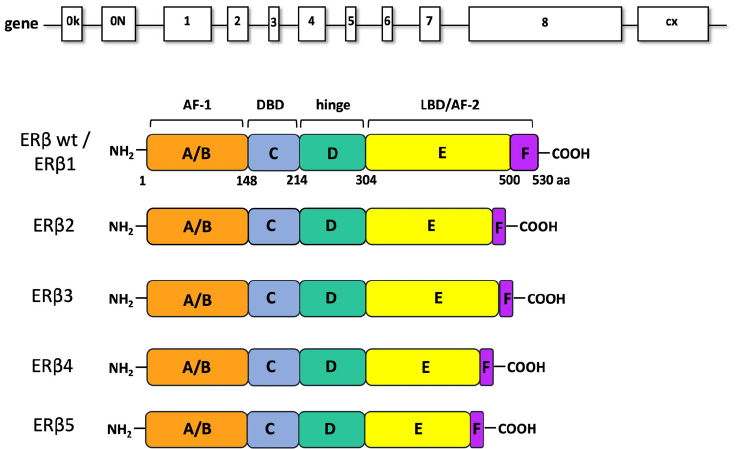
Figure 1. ER β gene and isoforms. In ER β gene representation, introns (lanes) and exons (boxes) are indicated. ER β wt (ER β 1 or ER β ) contains eight exons. The ER β splice variants differ for the ligand binding domain (LBD) and contains six exons. AF1: activation function 1; DBD: DNA-binding domain; AF2: activation function 2.